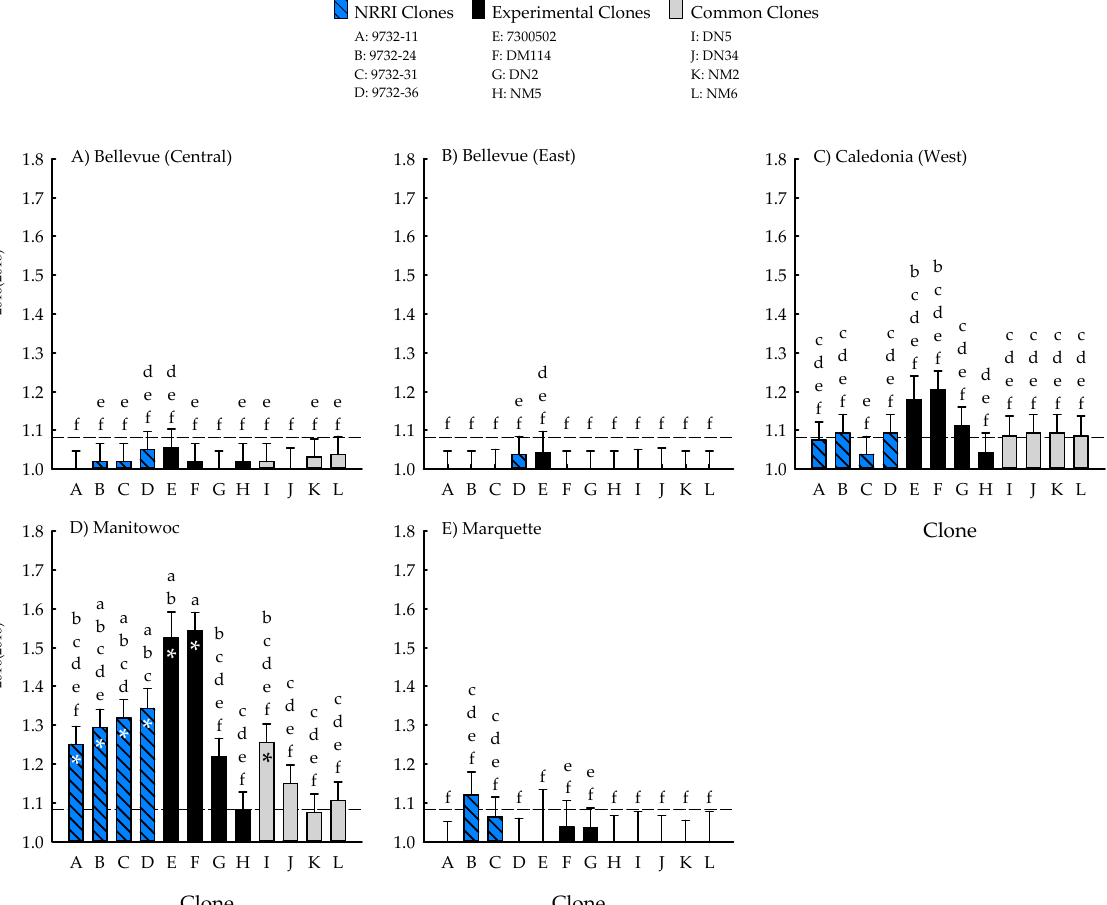
of 1.1 ± 0.0 (Figure 4). All trees were of optimal health. The healthiest trees were grown at Ontonagon (South), which had 13.7% better HEALTH 2019(2019) than at Escanaba (West) where trees had the poorest health. The range in health scores was narrower for